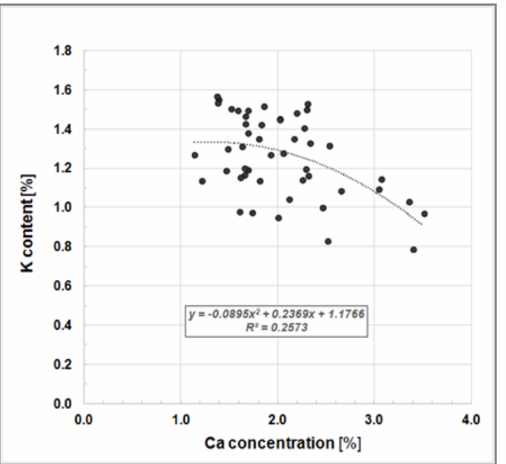
Figure 5. Bivariate scatter plot illustrating the K-to-Ca-antagonism, i.e., a negative relationship between K and Ca concentration in leaves of Black Locust trees growing on clonal test plot Welzow .